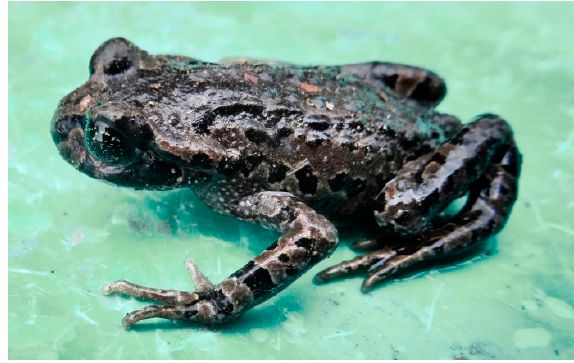
Figure 1. Scutiger cf. sikimmensis found in the Central Himalaya at 3289 m .